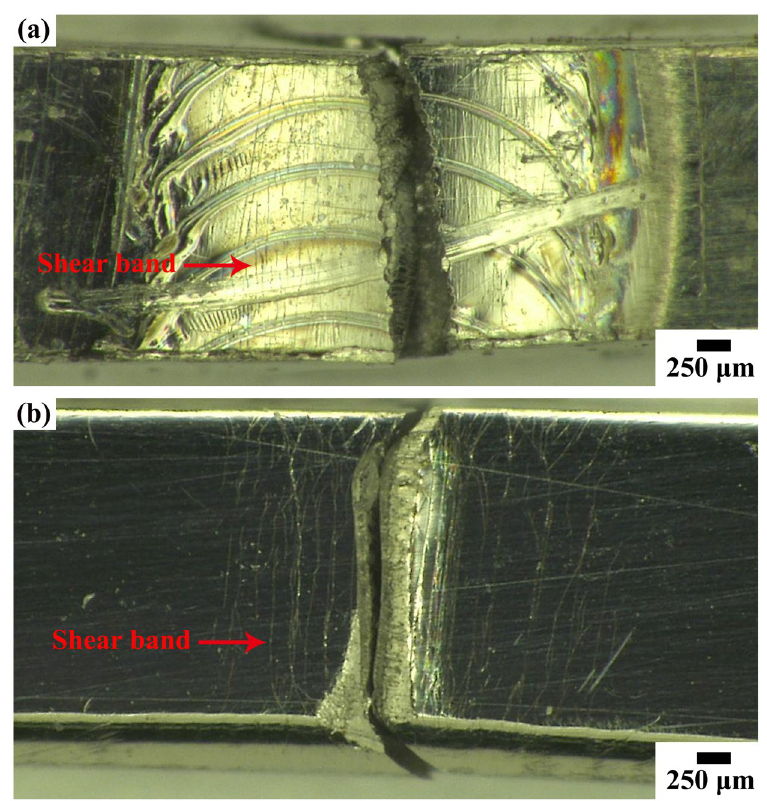
Figure 7. Fracture morphology after bend tests of Pd 43 Cu 27 Ni 10 P 20 bulk metallic glass: ( a ) weld joint; ( b ) base